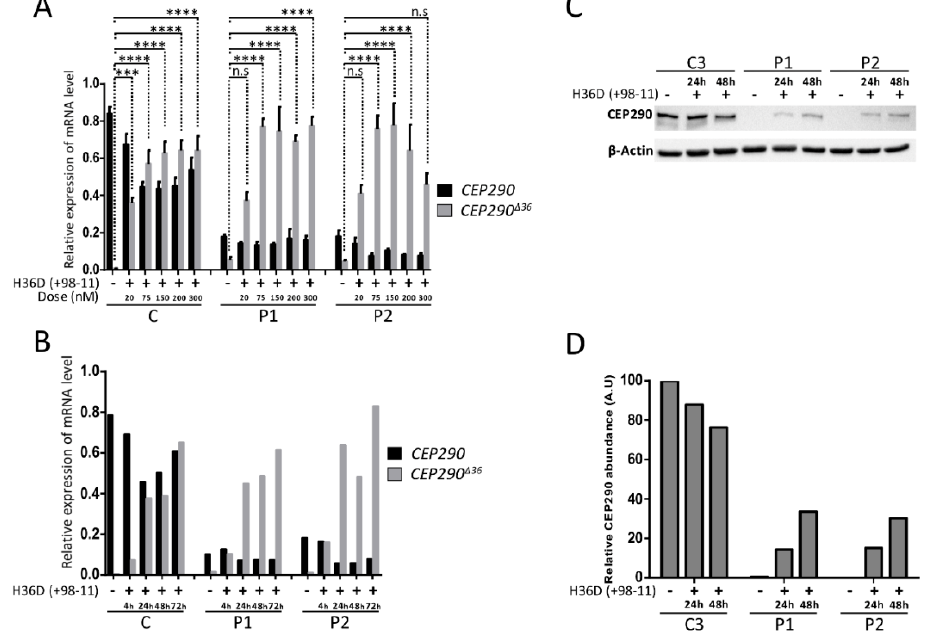
Figure 8. Optimization of transfection conditions. ( A ) RT-qPCR analysis of reverse transcribed CEP290 mRNA extracted from control (C1–C3) and patient (P1 and P2) fibroblasts untreated or after transfection of increasing doses (20 nM to 300 nM) of H36D oligonucleotide. The graph shows the mean amounts ( ± SEM) of full-length ( CEP290 ; black bars) and exon 36-skipped transcripts ( CEP290 ∆ 36 ; grey bars) from three independent experiments. C regroups the values obtained for C1–C3. *** p ≤ 0.001, **** p ≤ 0.0001, n.s., not significant. ( B ) RT-qPCR analysis of reverse transcribed CEP290 mRNA extracted from control (C1–C3) and patient (P1 and P2) fibroblasts untreated or treated during increasing times of treatment (4 h to 72 h) with 75nM of H36D oligonucleotide. The graph shows the amounts of full-length ( CEP290 ; black bars) and exon 36-skipped transcripts ( CEP290 ∆ 36 ; grey bars). C corresponds to C1–C3 pooled values. ( C ) CEP290 protein analysis in control (C3) and mutant (P1 and P2) cell lines untreated or treated with 75nM of H36D during 24 h or 48 h. ( D ) Relative quantification of CEP290 protein abundance depending on treatment time. β -Actin was used for normalization.